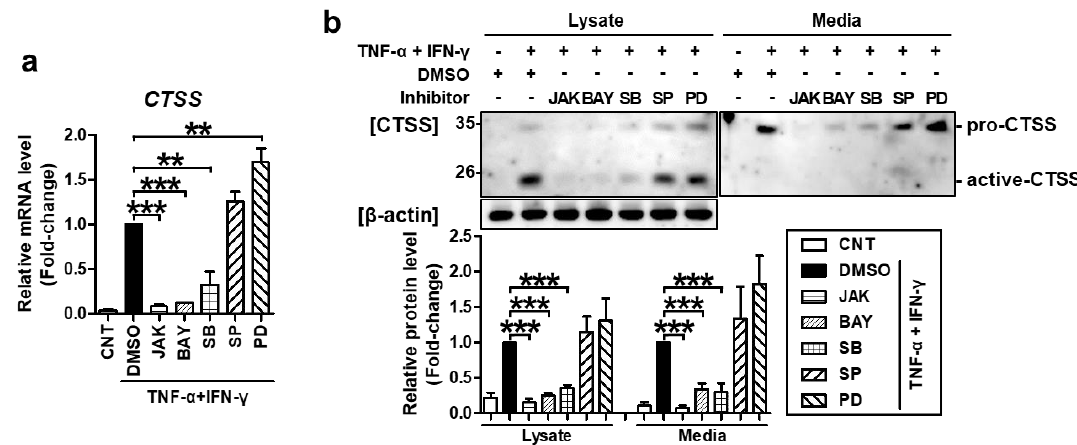
Figure 4. TNF- α /IFN- γ -induced CTSS expression was mediated by STAT1, NF- κ B, and p38 MAPK. Cells were treated as in Figure 3. ( a ) The expression of CTSS mRNA was measured by quantitative real-time PCR. ( b ) Protein levels of CTSS in cell lysates or conditioned media were measured by western blotting. Band intensity was analyzed using ImageJ software and the combined sum of pro and active CTSS band intensities was normalized to that of β -actin. The mRNA and protein levels, relative to those in the TNF- α /IFN- γ -stimulated DMSO control samples, are presented as mean fold-changes ± SEM of independent experiments (N = 3 or 4). Statistical comparisons were performed using a one-way ANOVA followed by Bonferroni’s post-hoc test (** p < 0.01, *** p < 0.001).